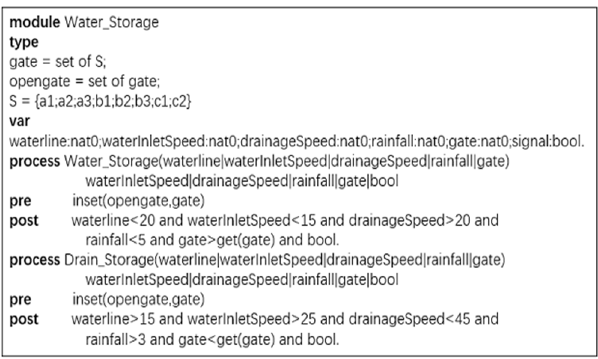
Figure 5. The specification of water storage function.